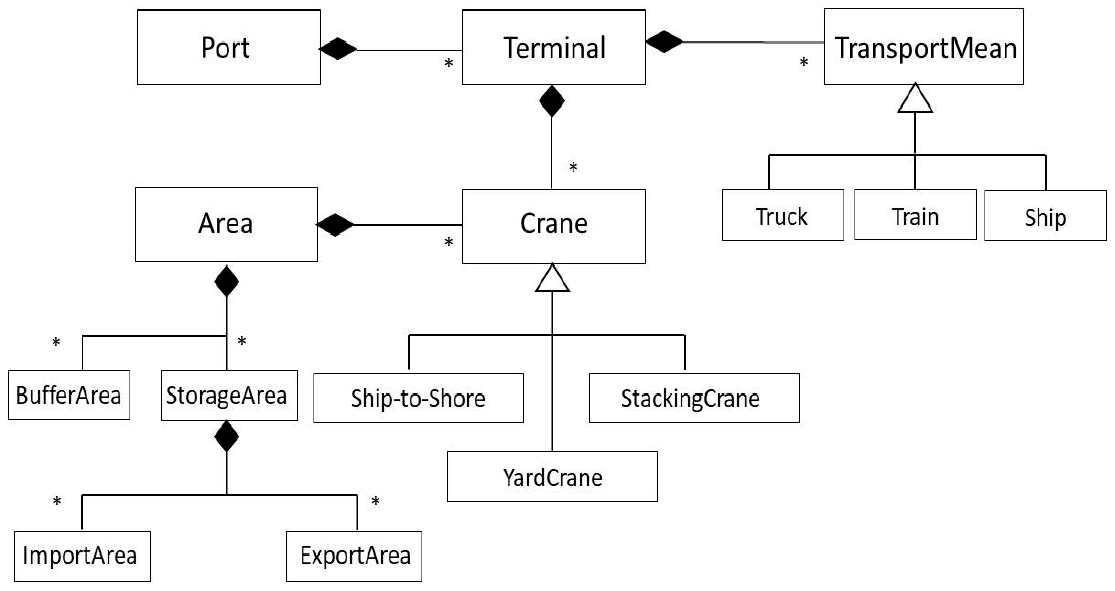
Figure 10. Class dagram of a container terminal’s physical structure.